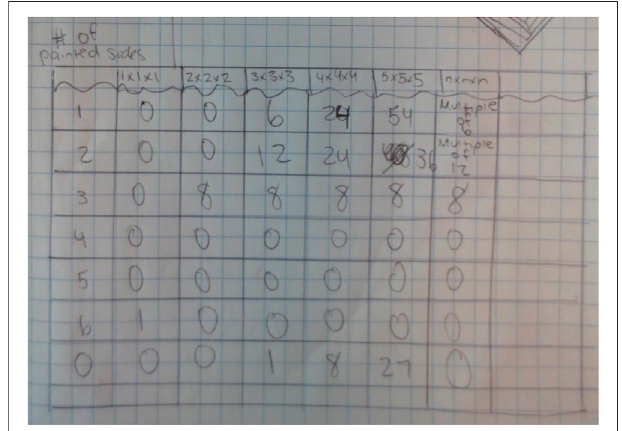
FIGURE 5 | Table of patterns from student ’ s